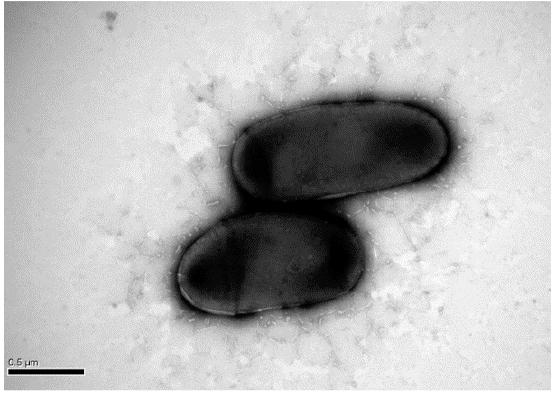
Figure 1. Transmission electronic microscopy (TEM) investigation of Gordonia sp. YC-JH1.